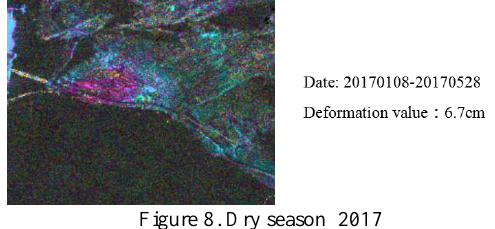
Figure 8. Dry season